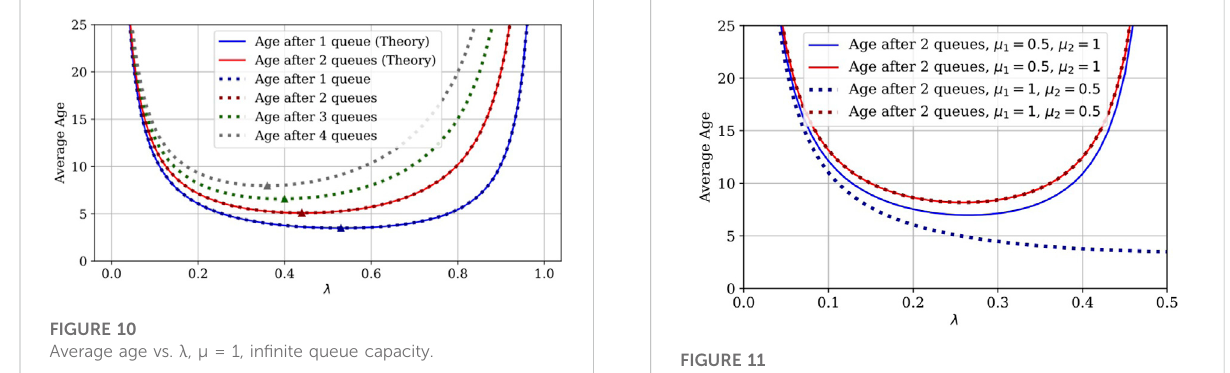
Average age vs. λ , different μ 1 , μ 2 , in fi nite queue capacity.